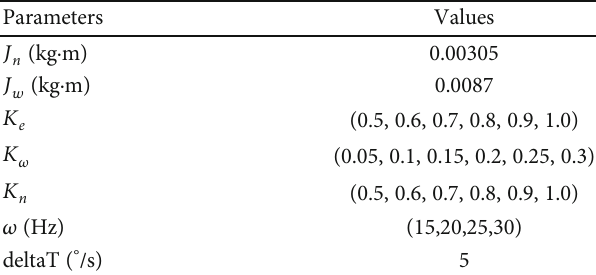
Table 1: Simulation